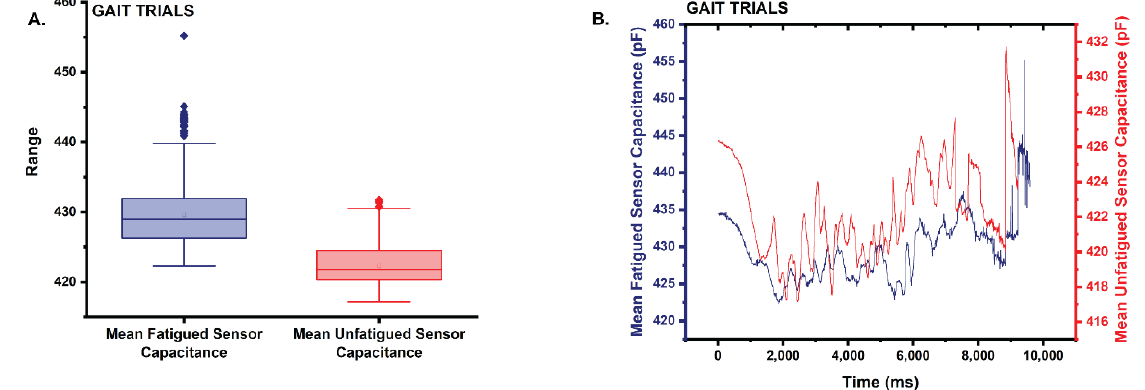
Figure 12. ( A ) Box plot of the statistics comparing the mean capacitance of the fatigued sensor to that of the unfatigued sensor during the gait trials. Note that the mean capacitance is higher for the fatigued sensor. ( B ) Plot comparing the mean capacitance of the fatigued sensor to the unfatigued sensor during the gait trials.